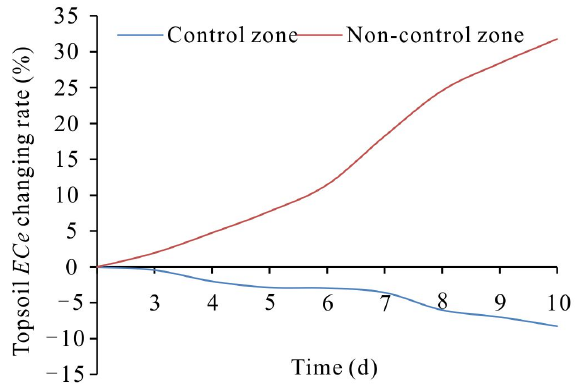
Figure 13. Changes in the moisture content in control and non-control zones.